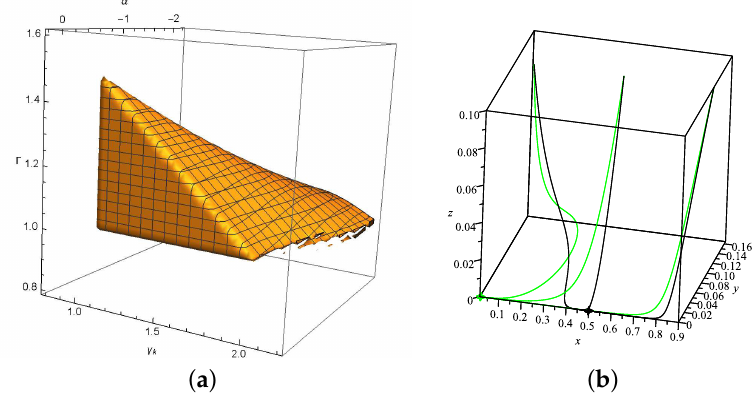
Figure 9. ( a ) The value ranges for parameters α , γ k and Γ to create and stabilize the critical point P e 2 ; ( b ) The 3-dim phase space around P e 2 with different coupling parameter α by fixing γ k = 6 Γ = 6 . When α = − 0.3, the black trajectories converge to P e 2 = ( 1 5 the green trajectories converge to P e 2 = ( 1